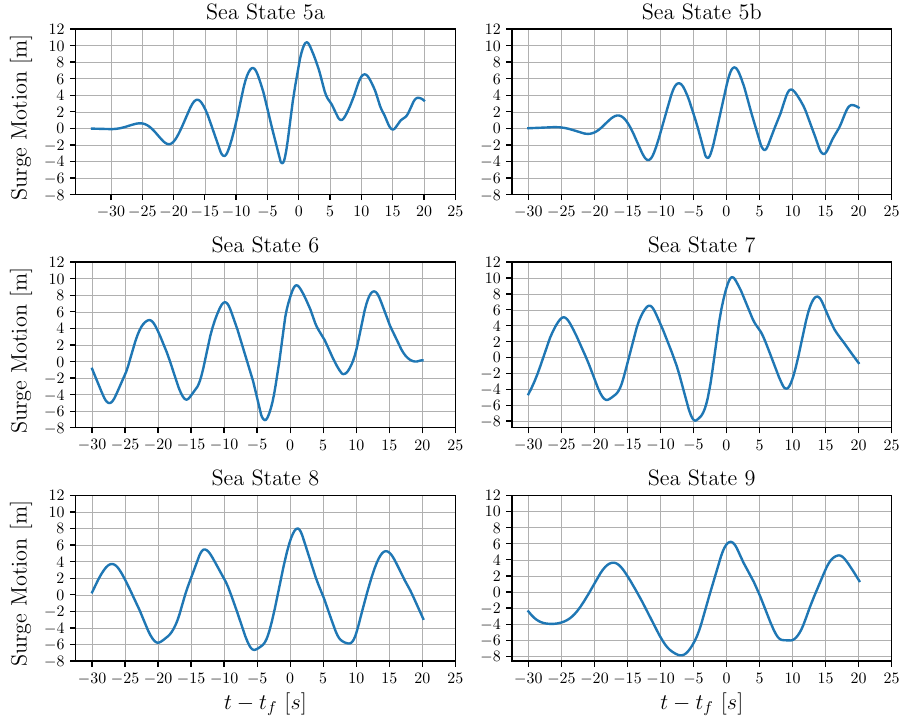
Figure 12. For all the examined sea states, the surge response time series during the wave–structure interaction is